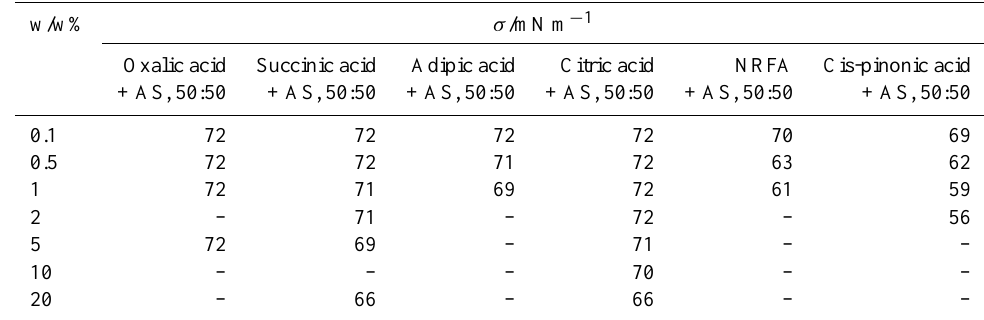
Table 2. Surface tension ( σ ) as a function of weight percentage (w/w%) for the mixtures with 50:50 mass ratio between an organic acid and ammonium sulphate (abbreviations are explained in Table 1).